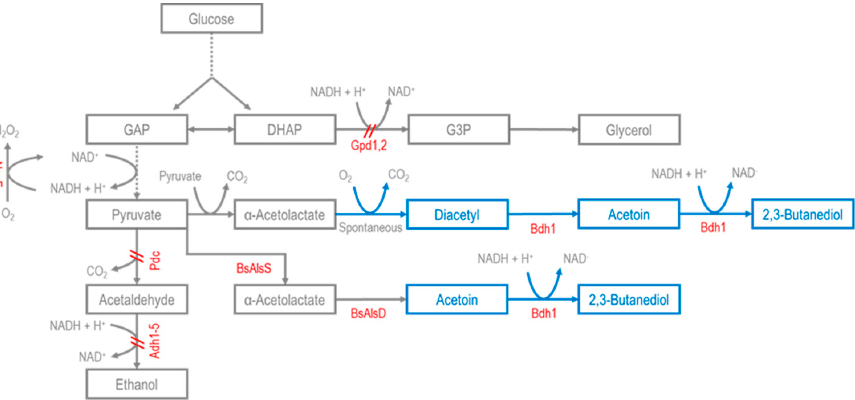
Figure 2. Example schematic of metabolic pathways in Saccharomyces cerevisiae for endogenous acetoin and 2,3-butanediol production and the heterologously expressed Bacillus subtilis acetoin/2,3- butanediol biosynthetic pathway with cofactor engineering utilizing NoxE from Lactococcus lactis (highlighting both acetoin and 2,3-butanediol). For metabolic engineering to produce acetoin, BDH1 is typically deleted. Adapted from previously published work (with detailed abbreviation descriptions) from Hahn and associates, described in subsequent